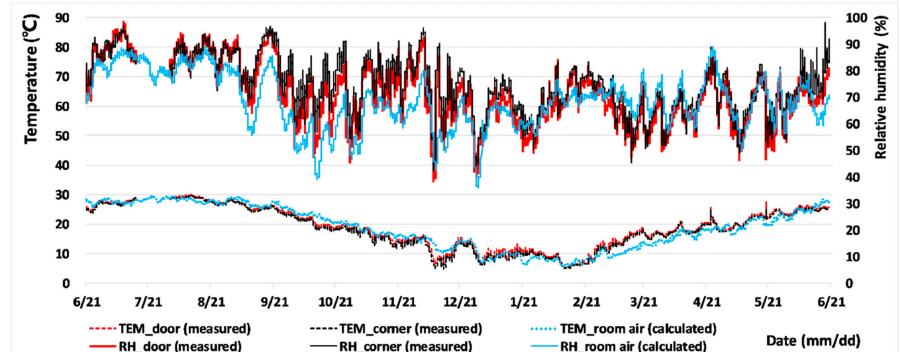
Figure 20. Comparison of the measured and calculated room temperatures and relative humidity.